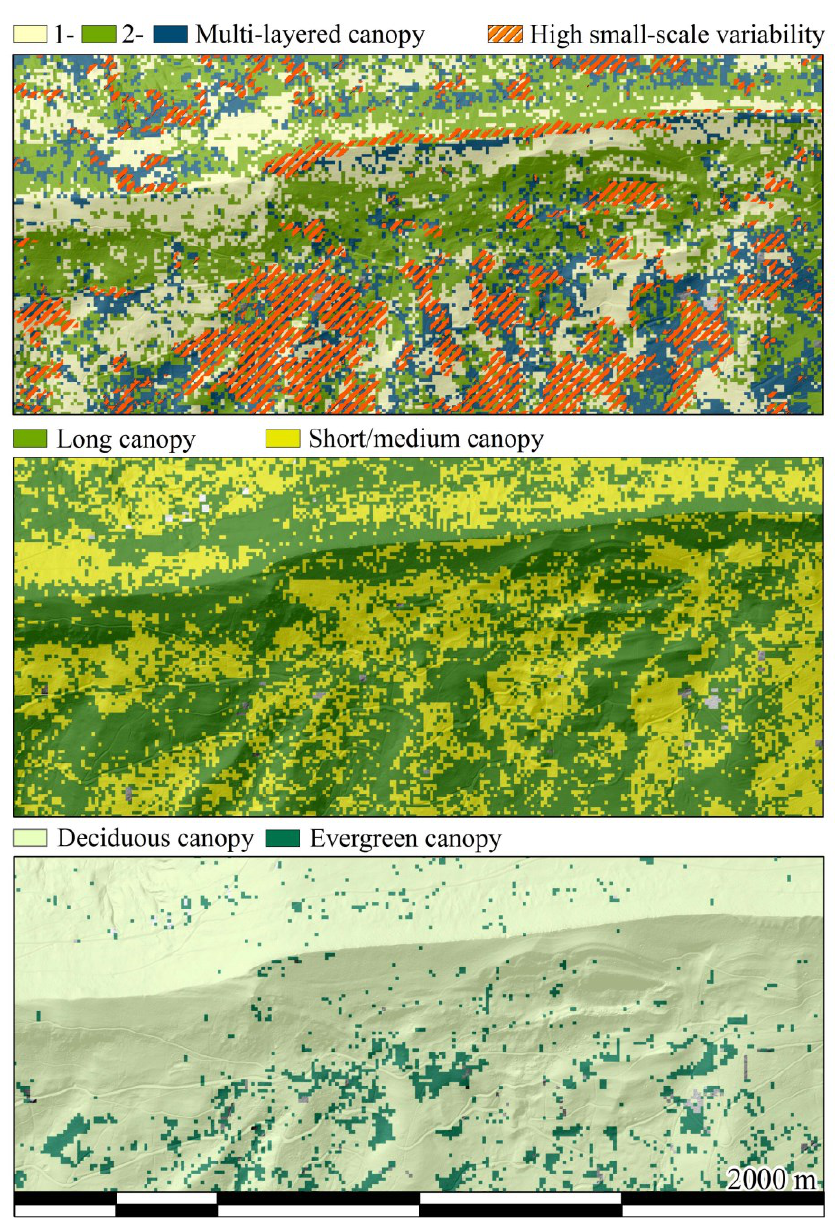
Figure 4. Canopy layering ( canopy layer ) and small-scale heterogeneity of the canopy ( canopy heterogeneity ) (top panel). Length of the topmost canopy layer ( canopy length ) (middle panel). Evergreen and deciduous canopies ( canopy type ) (bottom panel). All panels are a subset of the Laegern site, with a hill-shaded digital terrain model as